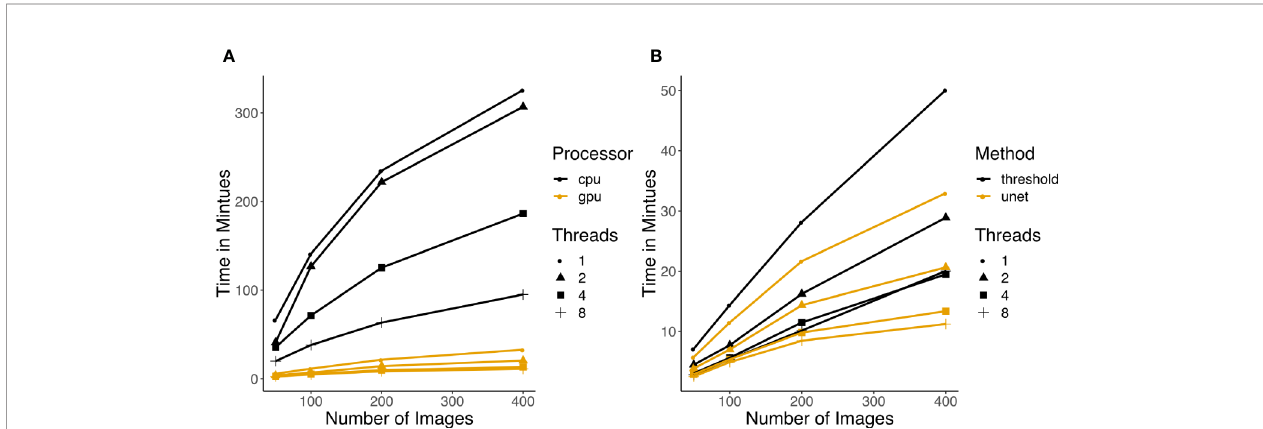
FIGURE 3 | (A) Running time of U-net using CPU versus GPU. Color indicates which processor was used and the shapes of the points represent how many threads were used for the running time measurement. (B) Running time of thresholding and U-net (GPU) with increasing number of images. Each run was done with 3 replicates and the median was taken. The colors represent which method was used and the shapes of the points represent how many threads were used for the running time